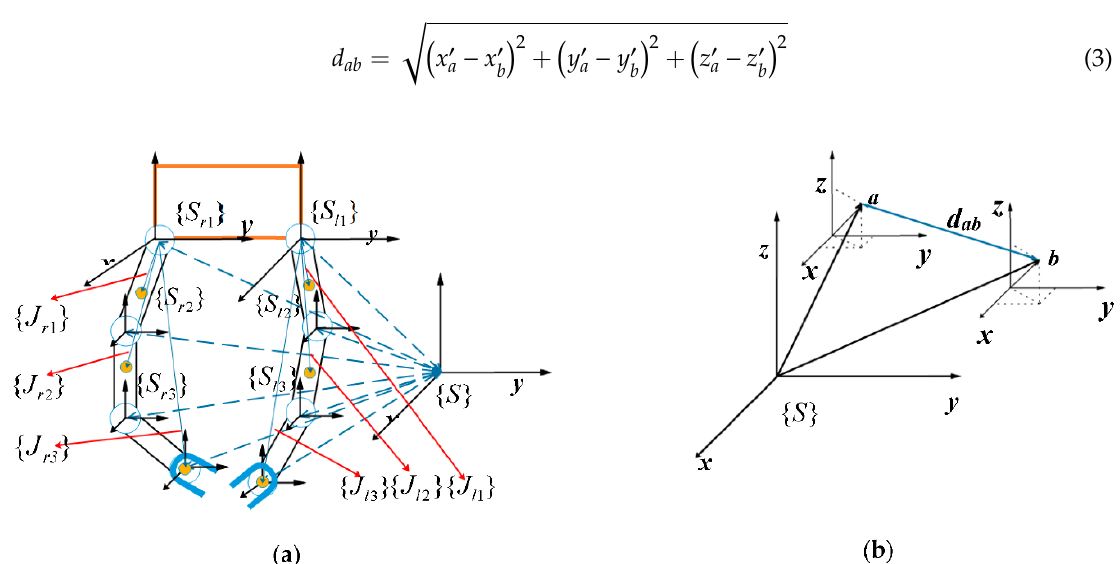
Figure 2. ( a ) Frame for the dual-arm robot. ( b ) Calculation of the distance d ad between point a and point b . point b